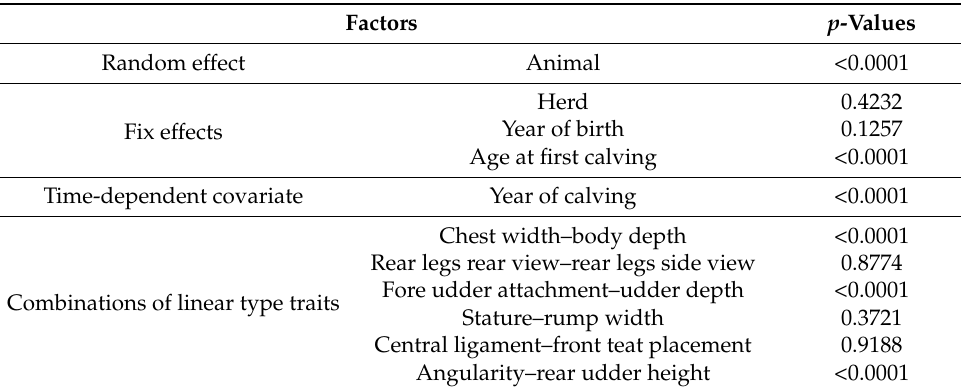
Table 2. Significant effects of some factors affecting